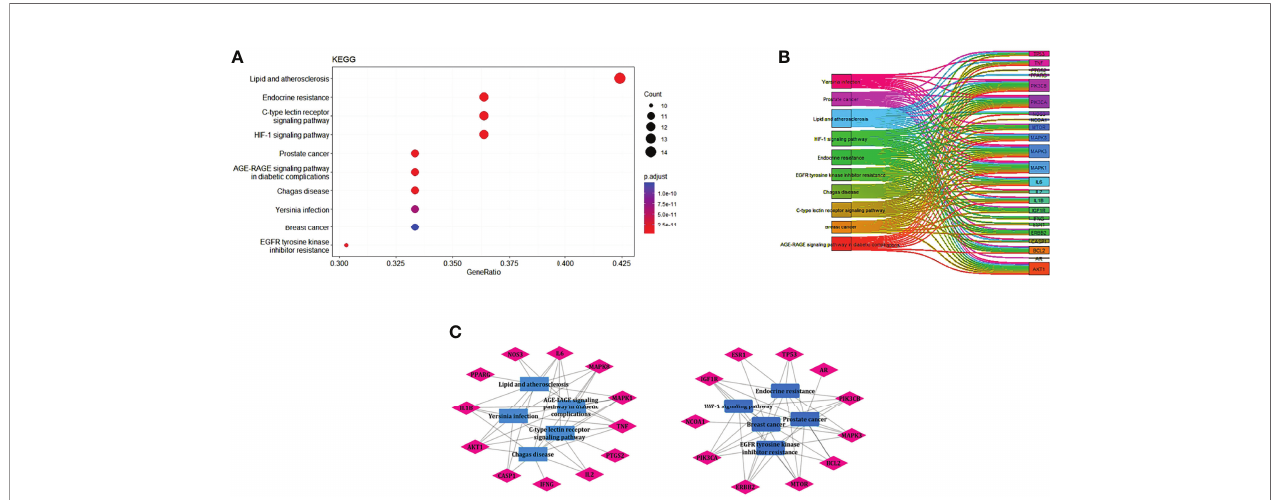
FIGURE 6 | The KEGG pathway enrichment analysis of the common 33 therapeutic targets. (A) Top 10 signi fi cantly enriched pathways. The dot sizes from large to small and colors from red to blue indicate count of genes and p- value in descending order. (B) Genes involved in the top 10 enriched pathways. (C) Community